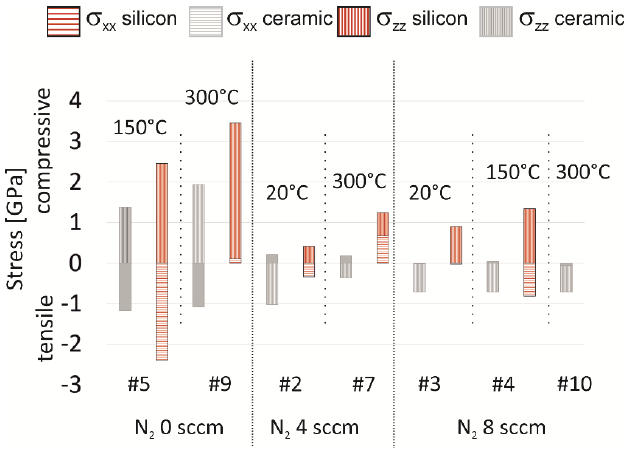
Figure 11. Layer stress depending on substrate material, ordered by gas atmosphere and heater